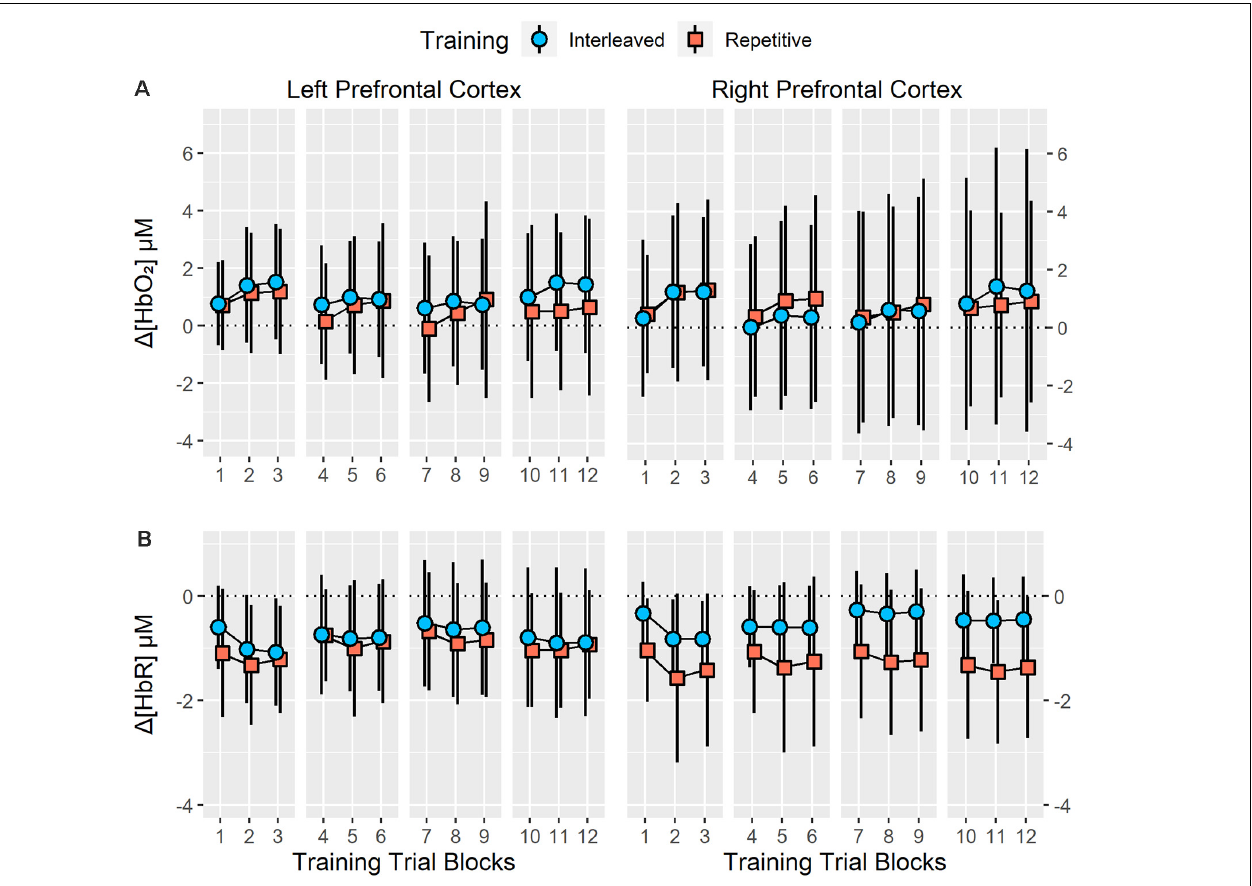
FIGURE 3 | Resting state to task related changes in right and left prefrontal cortex (PFC) oxygenated ( ∆ [HbO 2 ]; A ) and deoxygenated ([ ∆ HbR]; B ) hemoglobin concentration during 12 training trial blocks with four bimanual five-key press sequences under interleaved or repetitive training schedules. Analysis revealed no significant main effect or interactions of training groups on right and left PFC ∆ [HbO 2 ] or ∆ [HbR] (all p > 0.20). Error bars represent standard